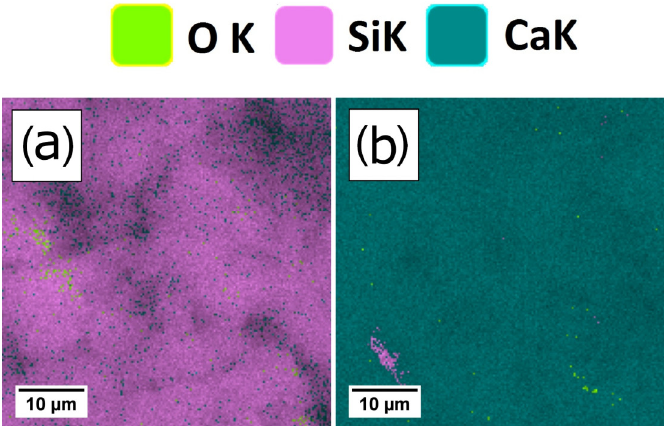
Figure 5. SEM-EDS elements maps of Si/Ca systems gel monoliths before calcination at the Ca/Si molar ratio: ( a ) 0.1; ( b ) 1.0.